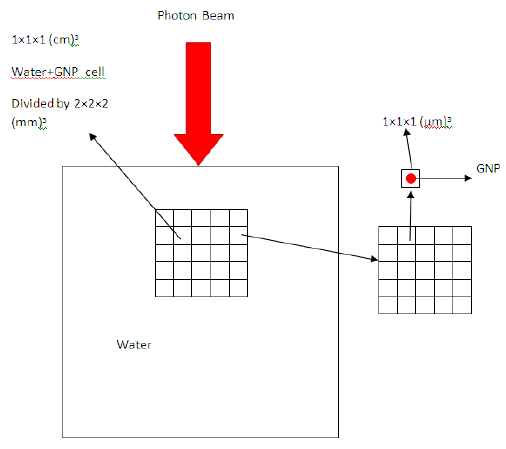
Fig. 1. A schematic view of the geometry simulated via MCNP5